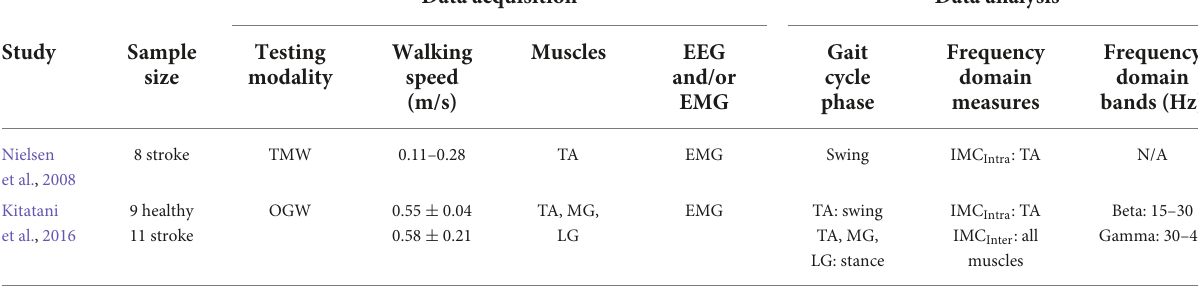
TABLE 2 Characteristics of studies that examined oscillations during neurological impaired